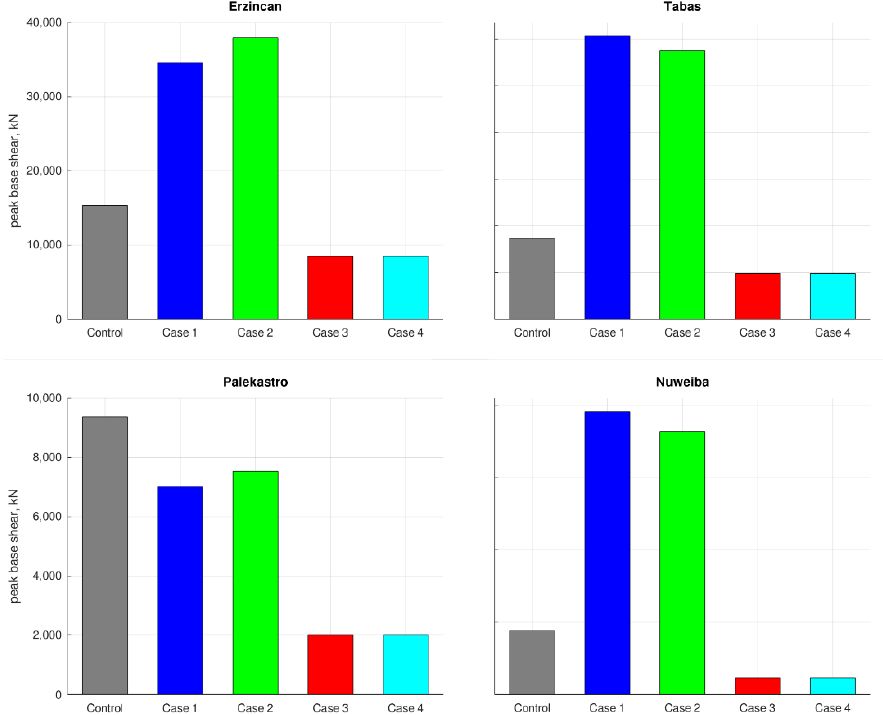
Figure 9. Peak base-shear responses to each earthquake.